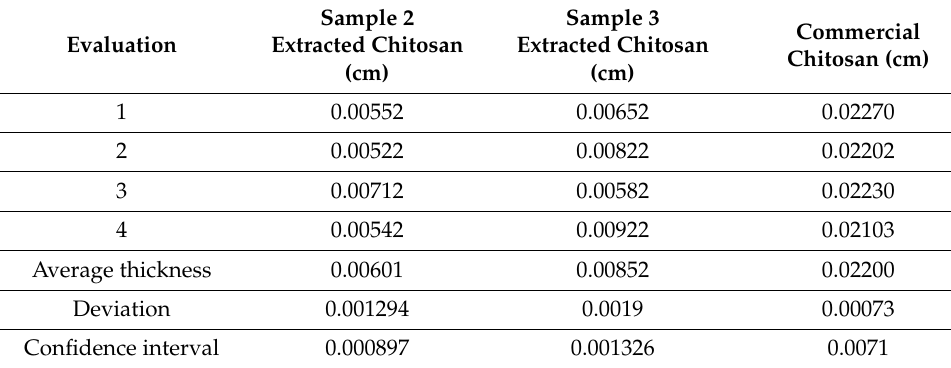
Table 2. Average thickness for chitosan biofilm